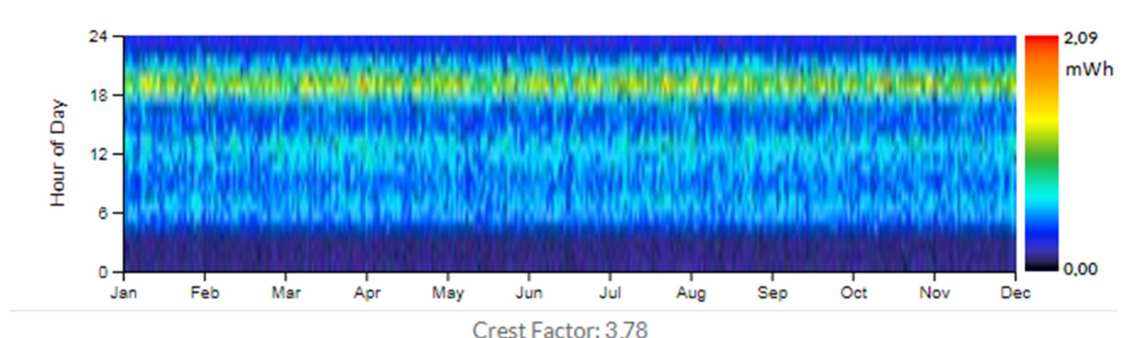
Figure 2. Energy Consumption Patterns in the Lubuskie Voivodeship. Source: own study using Homer Grid software.